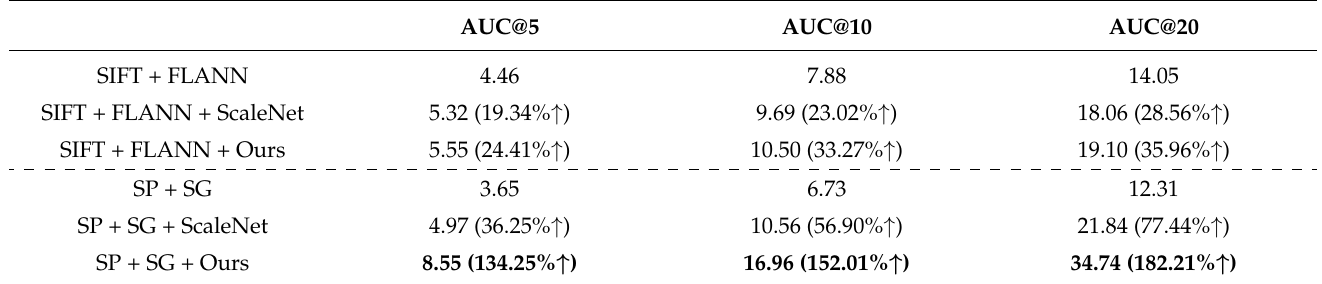
Table 5. Pose estimation in the FixedLight dataset.